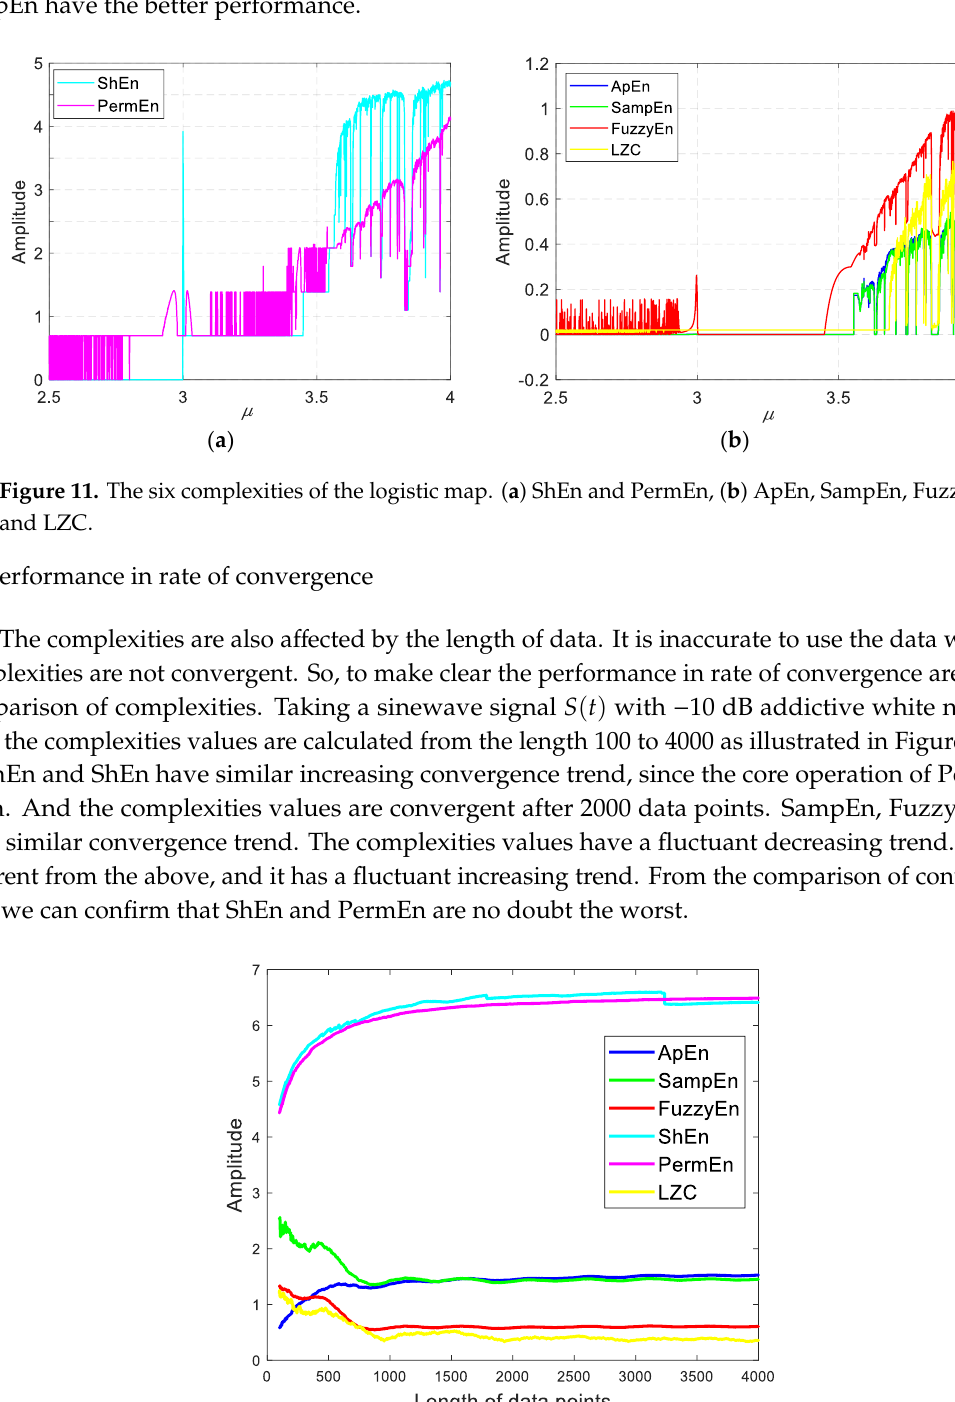
Figure 12. The curves of six complexities versus length of data points.